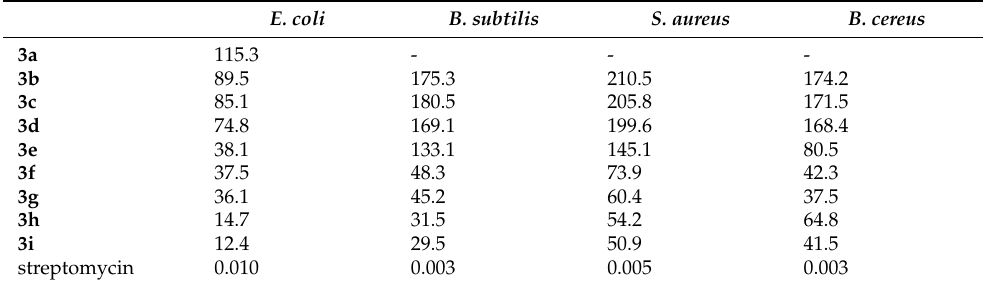
Table 1. Antimicrobial activity of 3a–i . MIC values are presented in µ M. E. coli B. subtilis